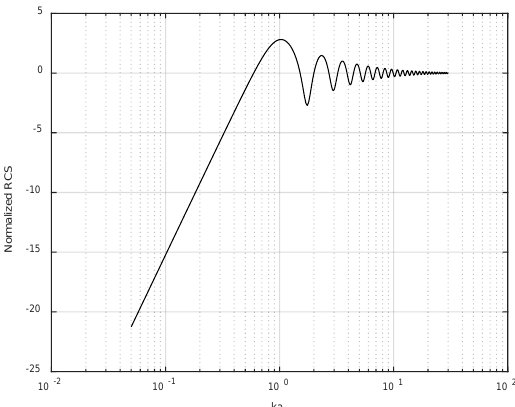
Figure 1. Radar cross-section (RCS) of a perfectly conducting sphere normalized to the optics value π a 2 .